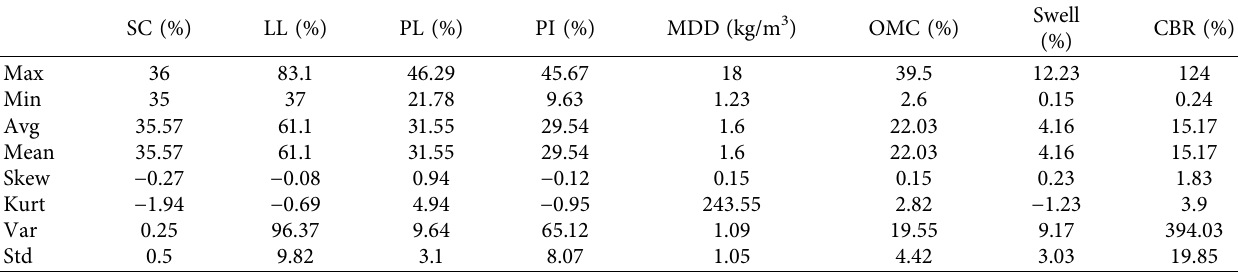
Table 2: Statistical value of the data in the